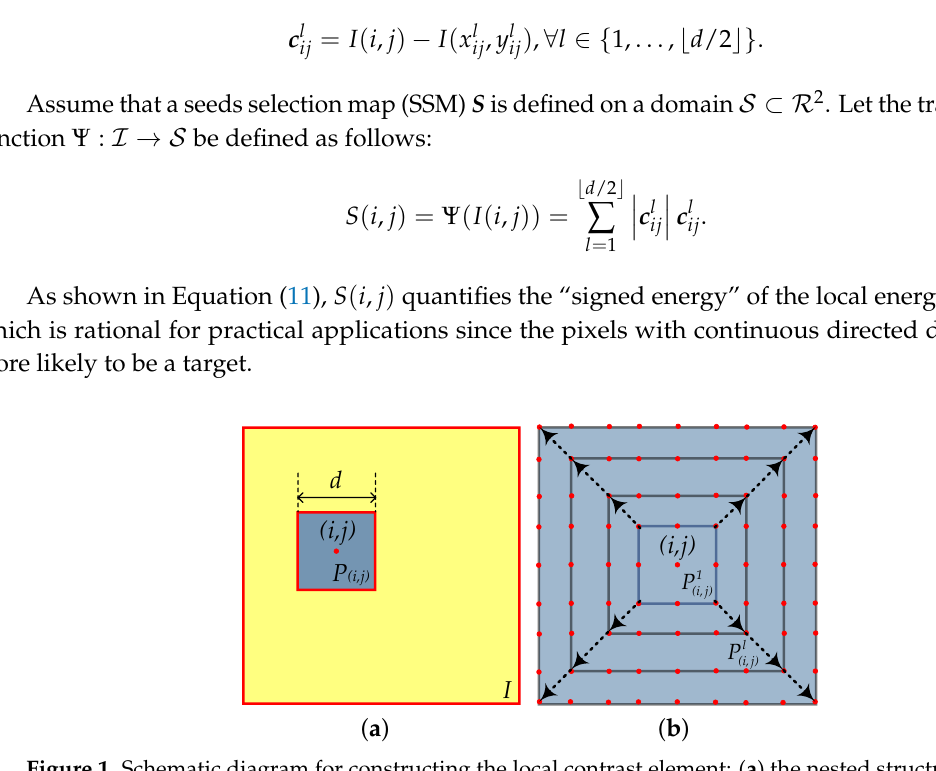
Figure 1. Schematic diagram for constructing the local contrast element: ( a ) the nested structure of the image; and ( b ) the diffusion structure of sub-patch P ( i , j )